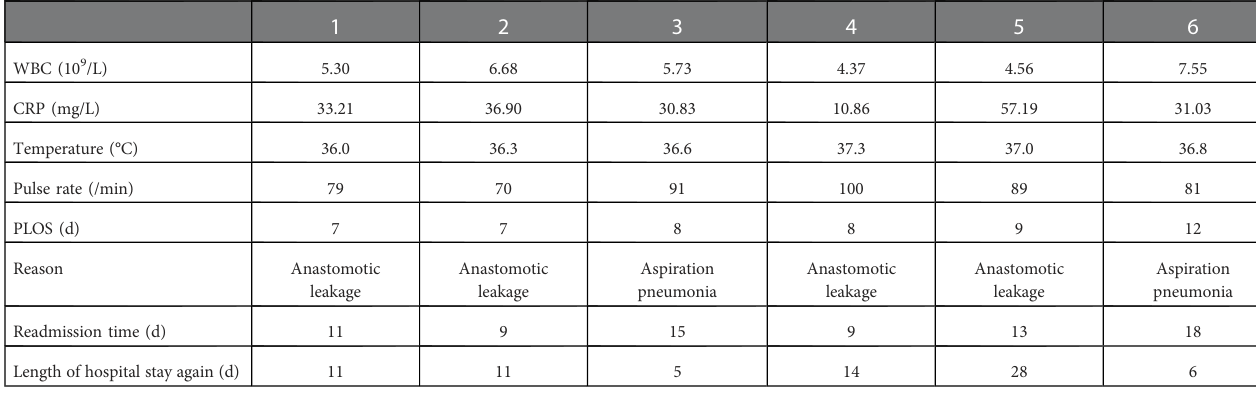
TABLE 4 General clinical data of patients readmitted within 1 month after